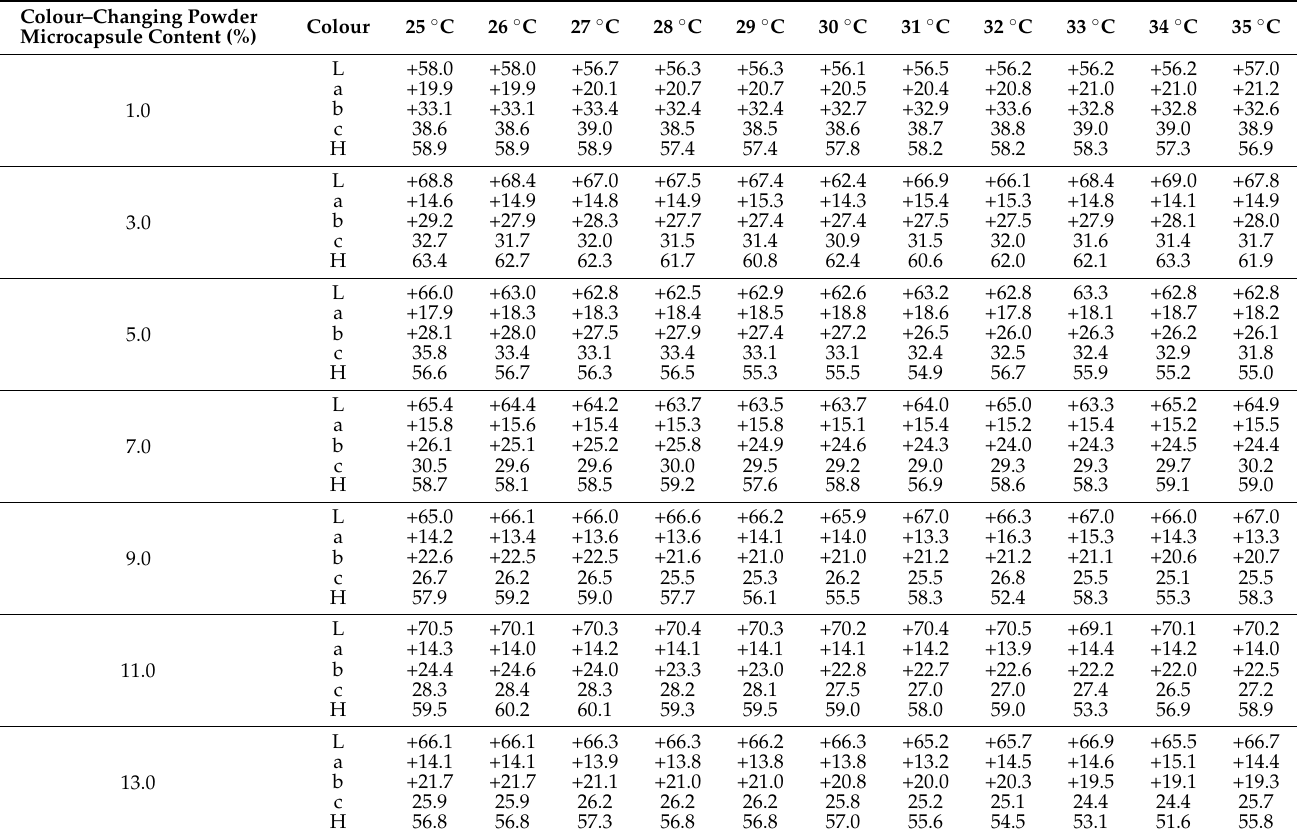
Table 3. Colour value of the coating with the core wall ratio 0.033 colour–changing powder microcap- sules from room temperature 25 ◦ C to 35 ◦